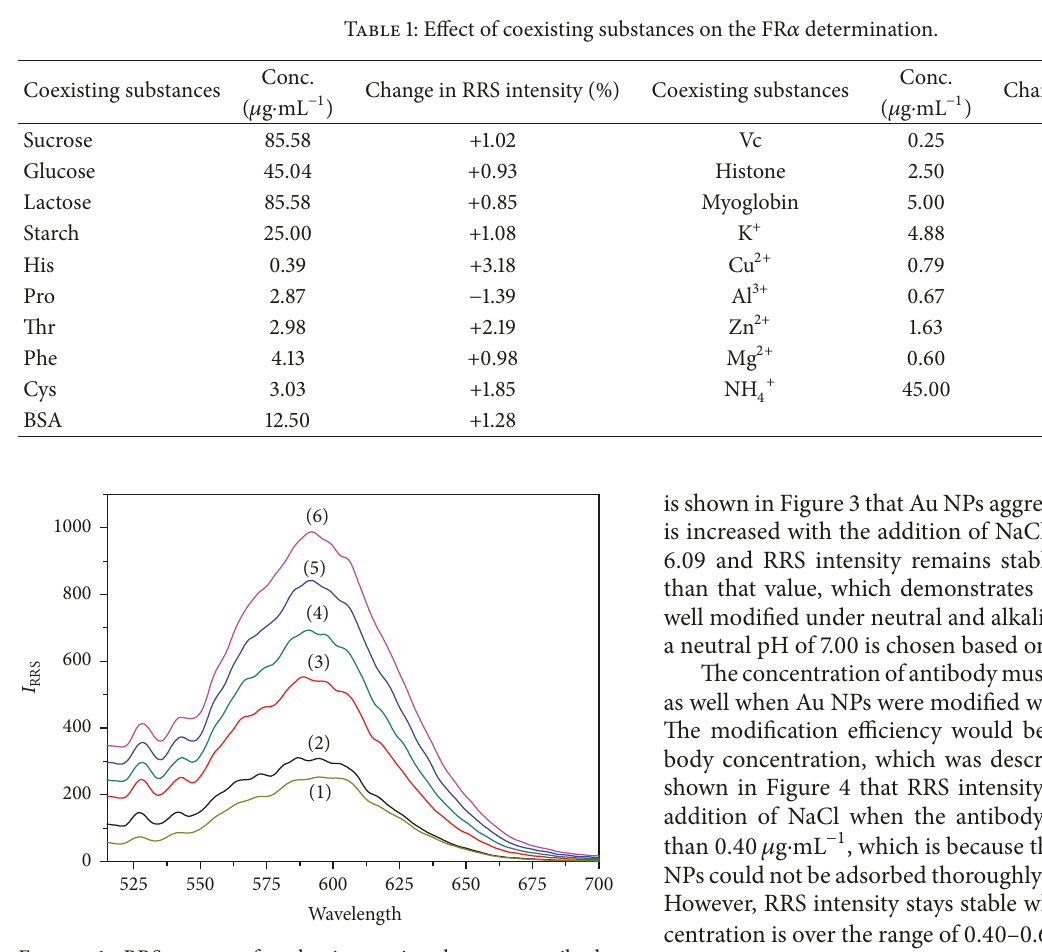
Figure 1: RRS spectra for the interaction between antibody- modified Au NPs probe and FR 𝛼 . Curve 1, original Au NPs; Curve 2, antibody-modified Au NPs probe; Curves 3–6, interaction between the probe and FR 𝛼 . Concentrations: FR 𝛼 (Curves 3–6, ng ⋅ mL −1 ), 2.50, 12.50, 25.00, and